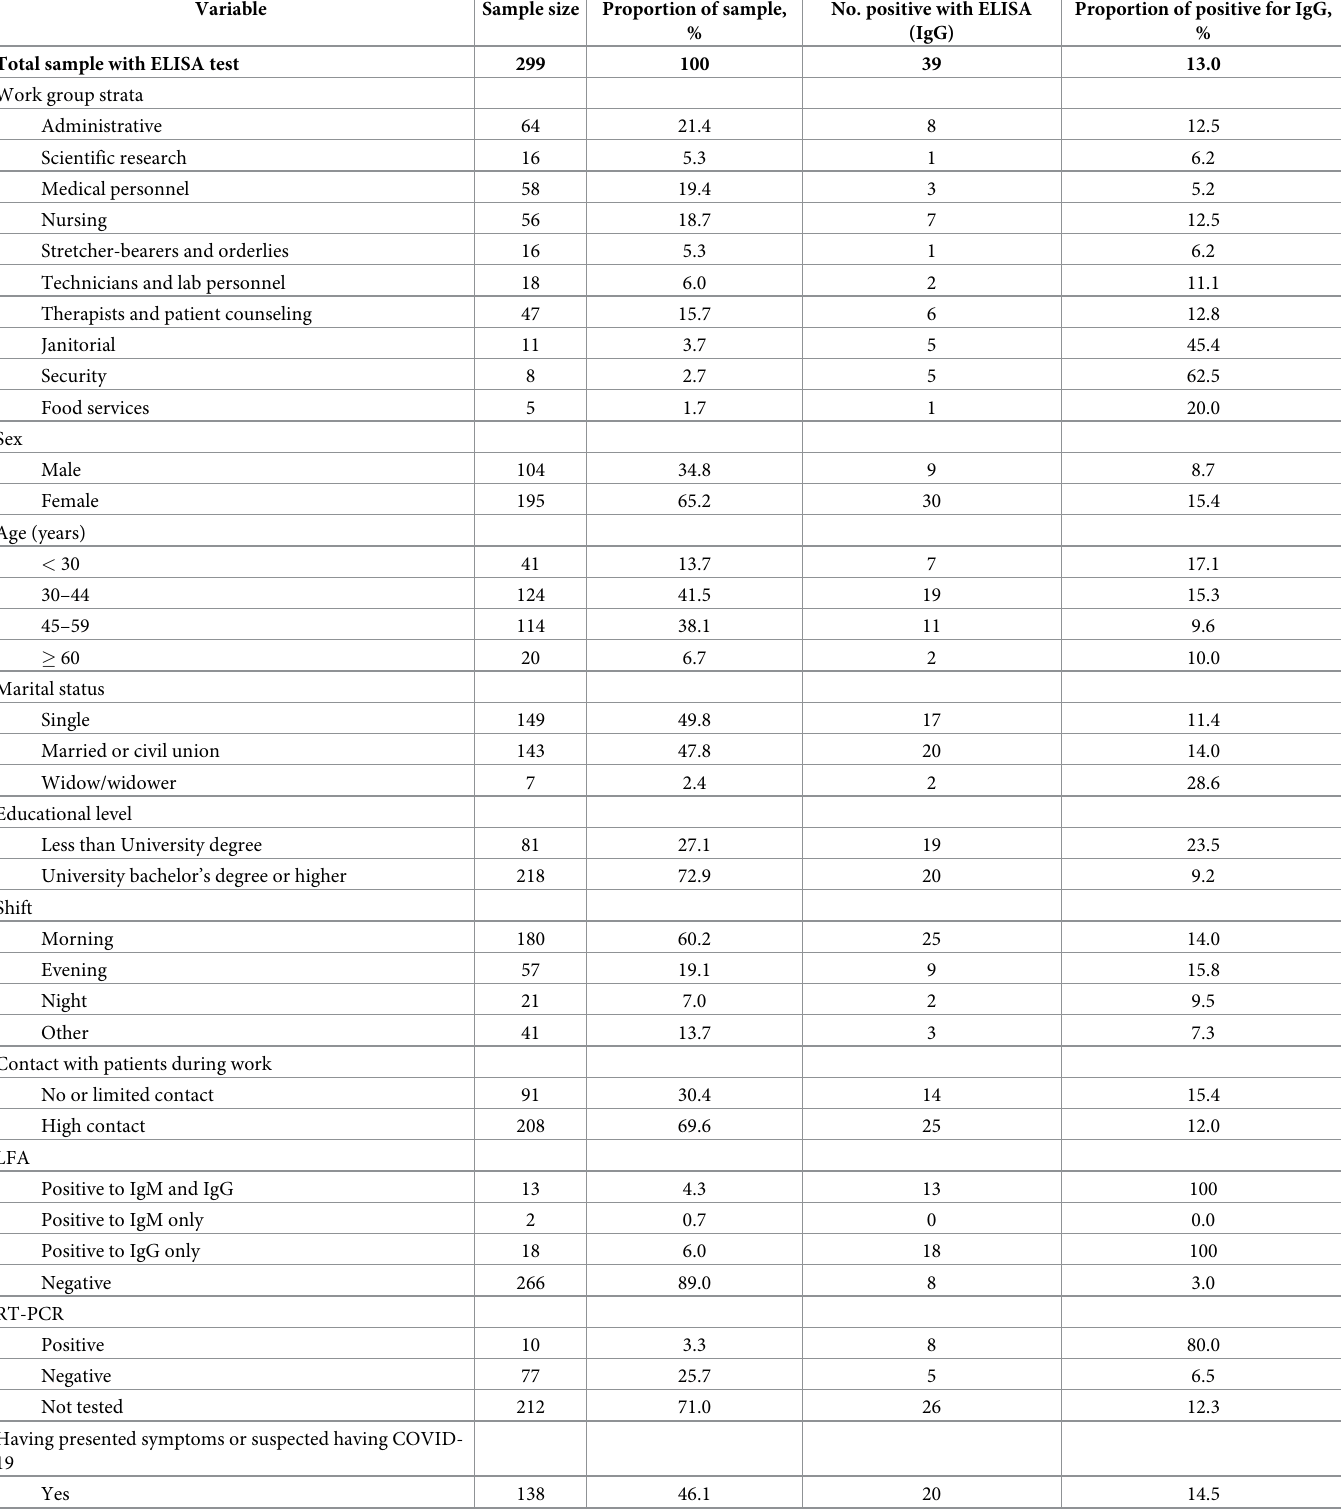
Table 1. General characteristics of the study population in relationship to the categorical ELISA test